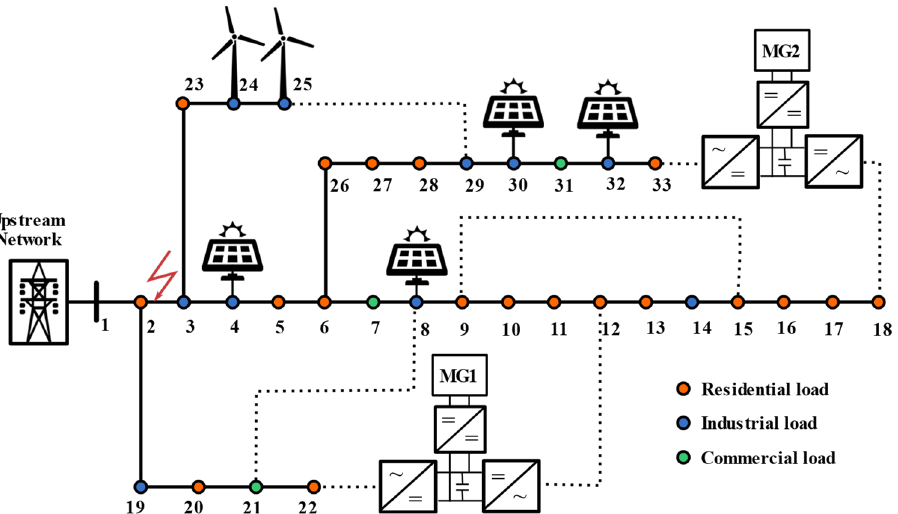
Figure 4. The modi fi ed IEEE 33 − bus system. Figure 4. The modified IEEE 33 − bus system. Table 1. Priority weight coefficient of load.